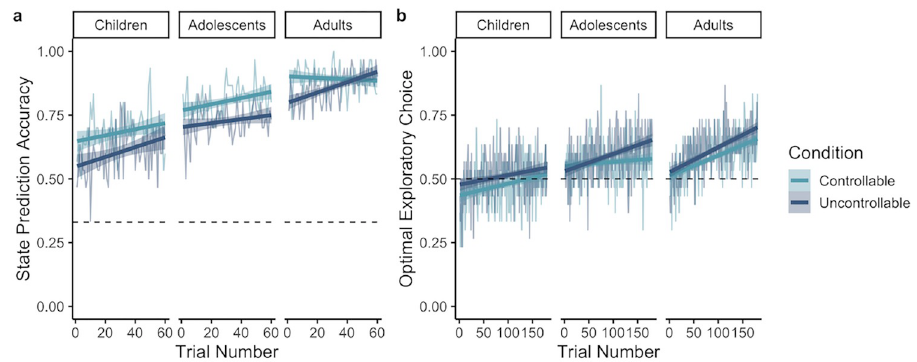
Fig 2. Performance on state predictions and exploratory trials over the course of the task. (a) Accuracy on state predictions and (b) diagnostic choices on exploratory trials are shown as a function of age group (children: 8–12 years, adolescents: 13–17 years, adults: 18–25 years), trial, and condition. Thinner lines represent the average performance for each group and condition, whereas the thicker lines represent the line of best fit with a 95% confidence interval. Chance performance is denoted by dashed